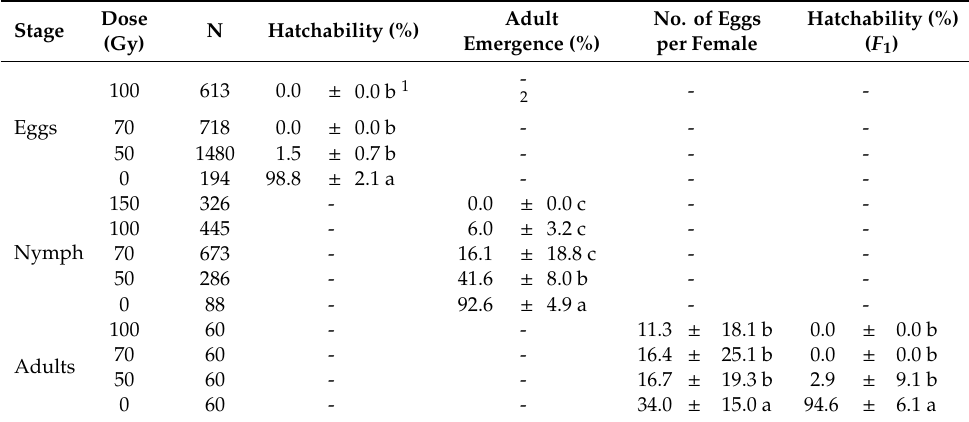
Table 2. E ff ect of x-ray irradiation on the hatchability, emergence, longevity, fecundity, and F 1 hatchability of T.